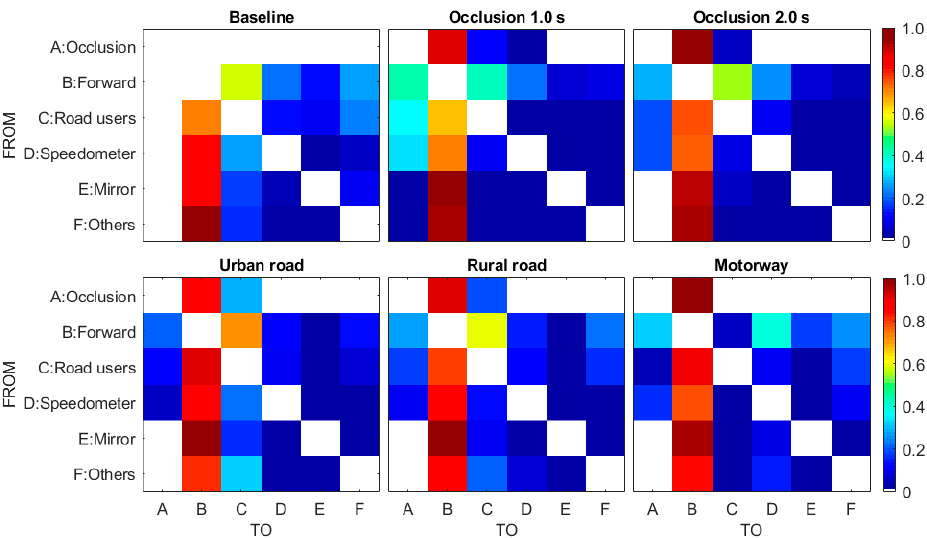
Figure 6. Glance transition graphs between the different AIOs. The colour indicates the probability of glance location moving from AOI Y to AOI X with warmer colour for greater value.